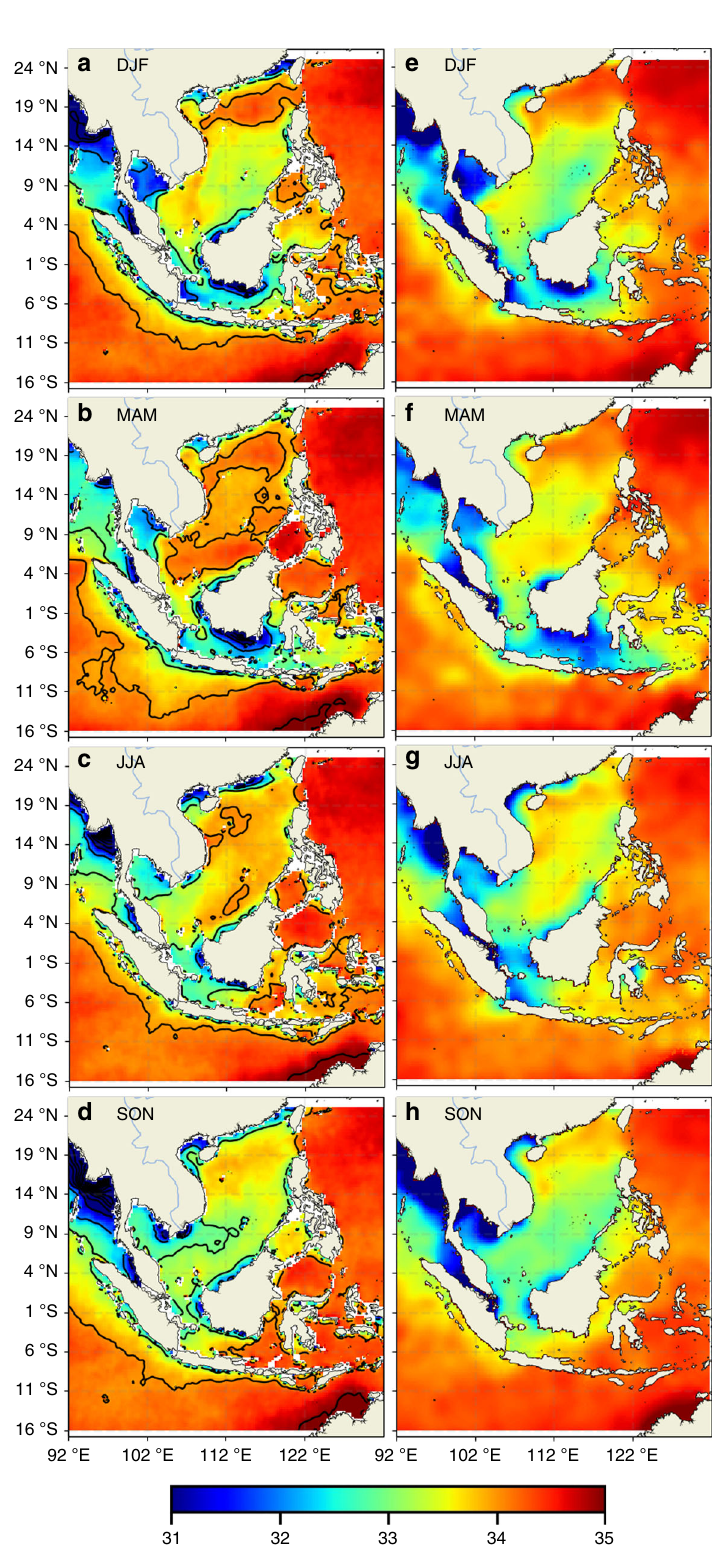
Fig. 2 Seasonal composites of sea surface salinity from the SMAP satellite and from the World Ocean Atlas 2013 climatology. a – d SMAP sea surface salinity composites for the DJF, MAM, JJA, and SON seasons. e – h World Ocean Atlas 2013 sea surface salinity climatology for the DJF, MAM, JJA, and SON